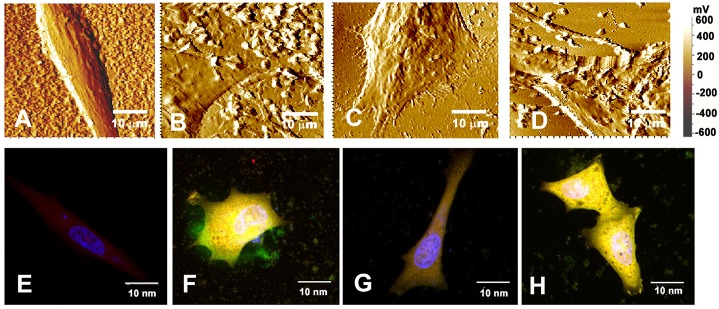
Inhibitory effect of plant enzyme on interaction of fibrin-Aβ42 co-aggregate with neuroblastoma cells
(A) Untreated cells; (B) deposition of preformed fibrin-Aβ42 co-aggregates on cell surface after incubation for 48 hr at 37°C; (C) removal of the co-aggregates from the cell surface after incubation with the plant enzyme; (D) residues of fibrin-Aβ42 co-aggregates on the cell surface after incubation with plasmin. The resolutions of images E-K were variable according to the area of selection to get a clear presentable image. (E) untreated cells with elongated morphology showing prominent blue nuclei (DAPI stained) and very faint expression of Aβ42 appearing as red as Alexa fluor 633 conjugated anti-rabbit secondary antibody was used against rabbit polyclonal antibody to Aβ1–42 peptide; (F) cells treated with fibrin-Aβ42 co-aggregate showing intense greenish-yellow fluorescence (as human fibrinogen conjugated with FITC showing green fluorescence and Aβ42 showing red fluorescence colocalized) indicating penetration of the co-aggregate inside the cells and deposition on the extracellular surface. The cells have markedly different morphology from untreated cells. (G) Cells treated with co-aggregate preincubated with plant enzyme showing morphology and absence of localization of the co-aggregate similar to that of the untreated cells as of (E); (H) cells treated with co-aggregate preincubated with plasmin showing failure of prevention of its localization within the cells and deposition on the cell surface. The morphology also differs from the untreated cells. The magnification of all images was 60X and resolution was 10 nm.